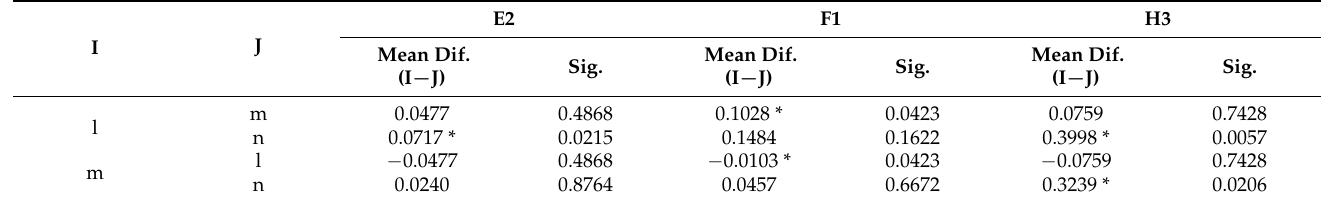
Table 8. Multiple comparison analysis of sensory perception indicators of riverside parks in different districts (only some important data are displayed here; all data can be found in the Supplementary File in the Supplementary